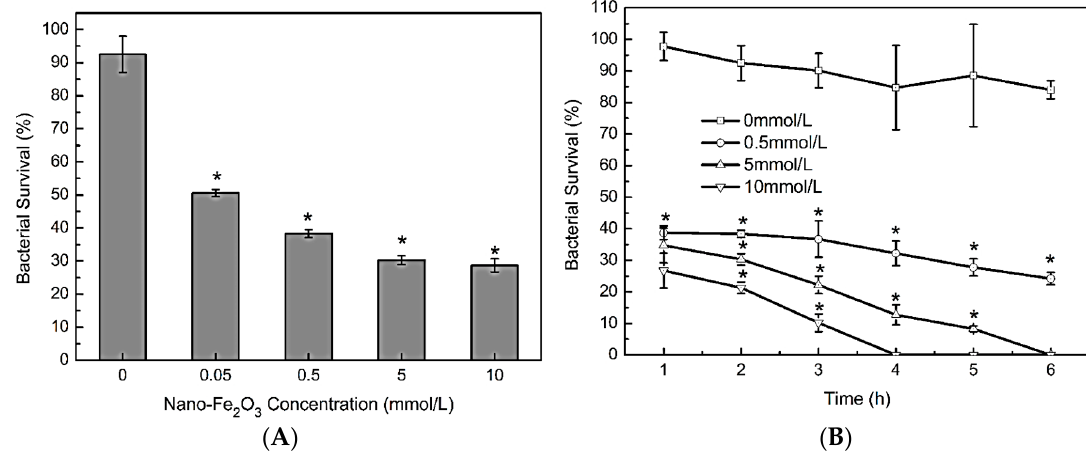
Figure 1. Culturabilityloss of Escherichia coli induced by iron oxide nanoparticle exposure in PBS. ( A ) E. coli MG1655 at 10 7 colony forming units (CFU)/mL were exposed to 0, 0.05, 0.5, 5, or 10 mM iron oxide nanoparticles at pH 7.4 and 37 °C for 2 h.The presence of iron oxide nanoparticles significantly reduced the culturability of the bacteria (ANOVA, p < 0.05); significant differences between each concentration of the nanoparticles and the control (0 mM) were found with the Student–Newman–Keuls (SNK) test, * p < 0.05; ( B ) E. coli MG1655 at 10 7 CFU/mL was exposed to 0.5 mM iron oxide nanoparticles for different time periods at pH 7.4 and 37 °C. With prolonged exposure to iron oxide nanoparticles, bacterial viability was significantly reduced (ANOVA, p < 0.05); significant differences between the iron oxide nanoparticle group and the control (0 mM) at each time point were tested by the SNK test, * p < 0.05.